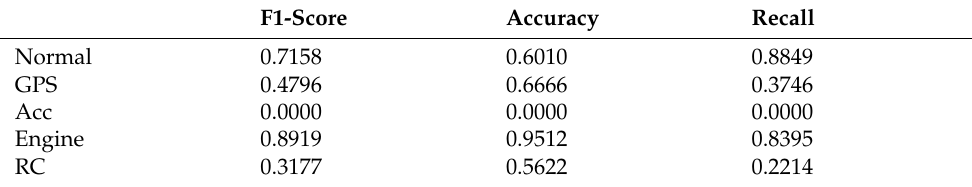
Table 18. Results of VIBE